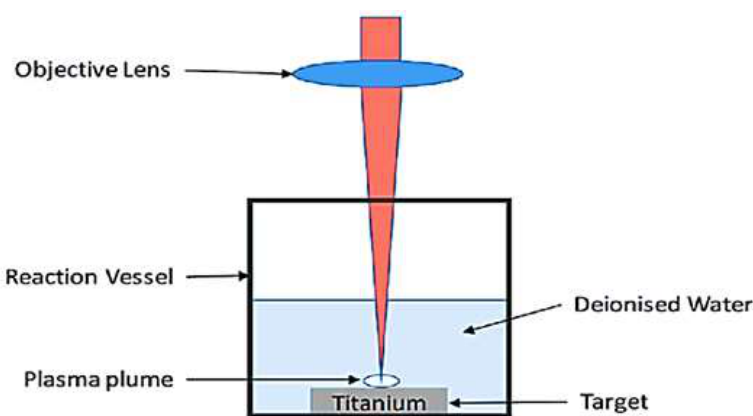
Figure 1 : A schematic representation of ablation process of titanium target in water by laser